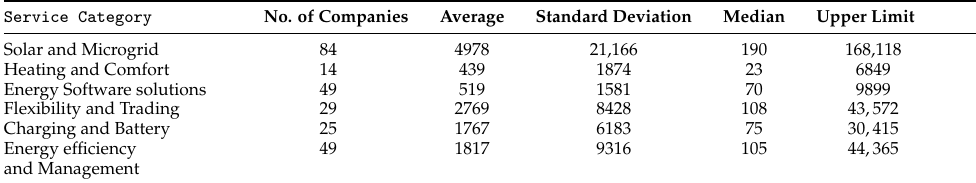
Table 3. Shareholder’s funds (th